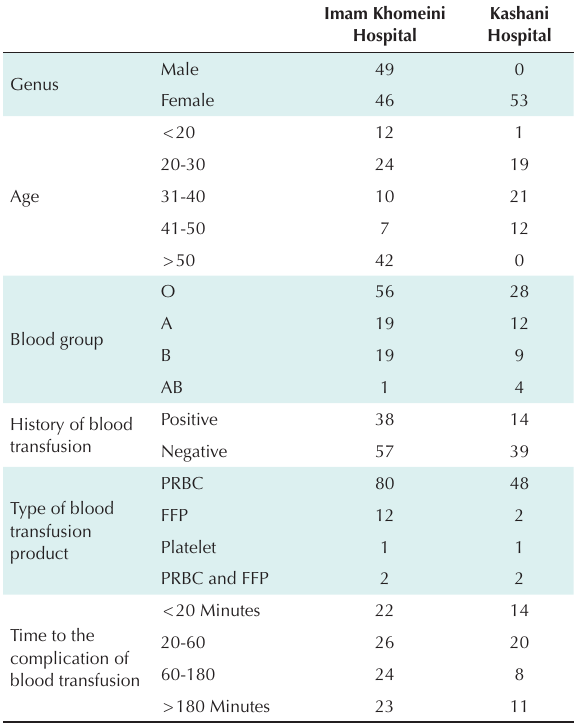
Table 1. Details of Complications of Blood Transfusion in Imam Khomeini and Kashani Hospitals